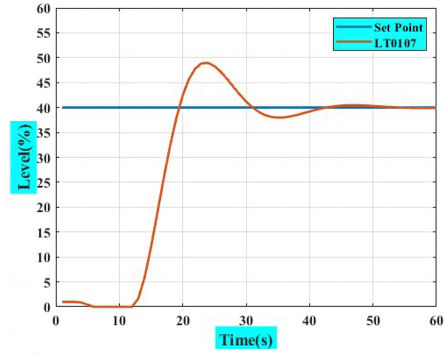
Figure 6. System response with manual tuning.